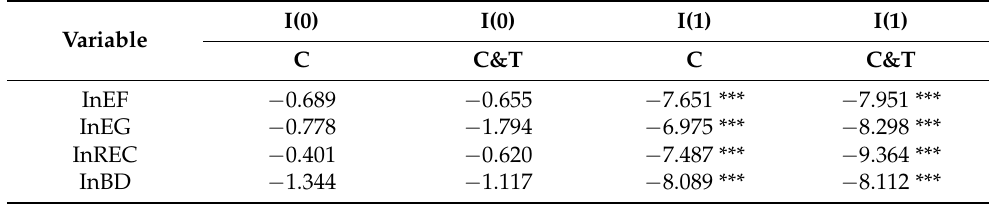
Table 3. The findings of Im, Pesaran, and Shin unit root